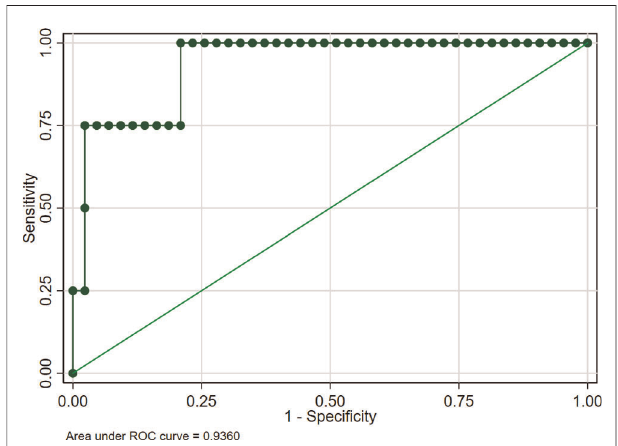
FIGURE 1 | Receiver operating characteristic curve for the predictors of complication after conservative surgery of intestinal deep endometriosis.